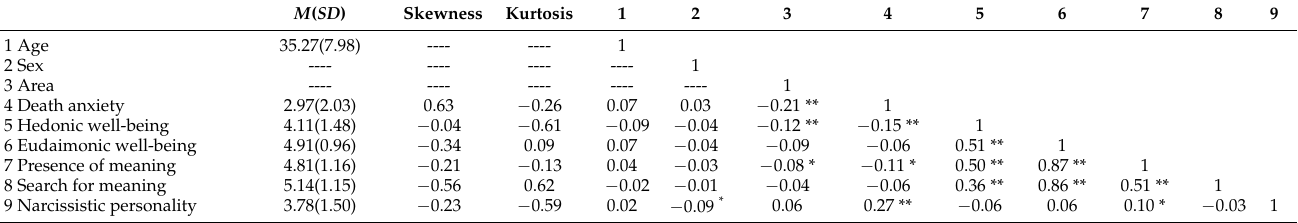
Table 1. Descriptive Statistics and Correlation Analysis of the Present